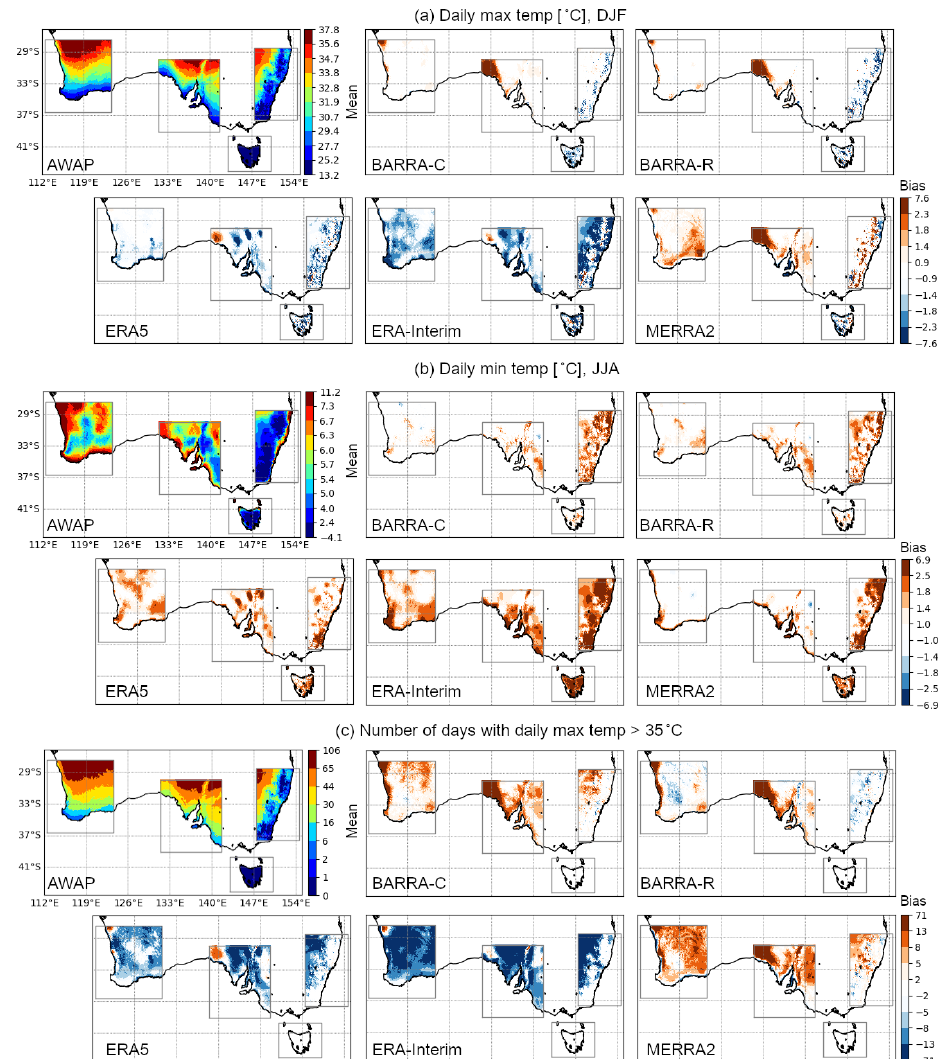
Figure 3. Mean difference in (a) summer (DJF) daily maximum temperature, (b) winter (JJA) daily minimum temperature, and the (c) number of days with temperature exceeding 35 ◦ C in various models during 1990–2018 with respect to AWAP. The models are regridded onto the AWAP grid using nearest-neighbour